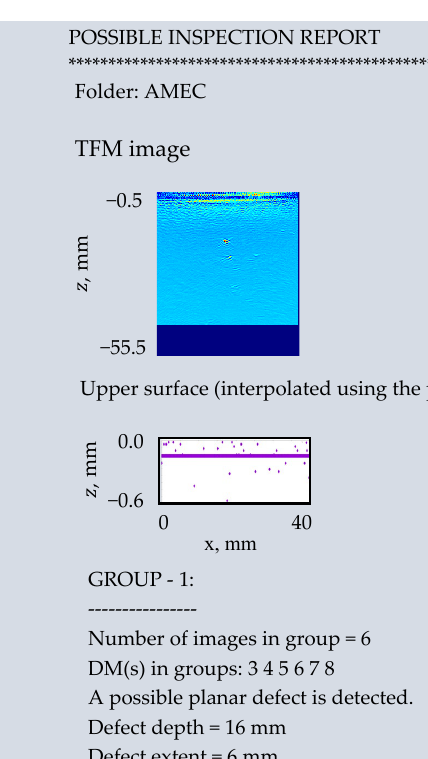
Figure 12. The AMEC data set. ( a ) The standard TFM image of the full specimen; ( b ) an MTFM image, with 20% thickness cut off the bottom, intensity threshold = 125, Dm = 3.